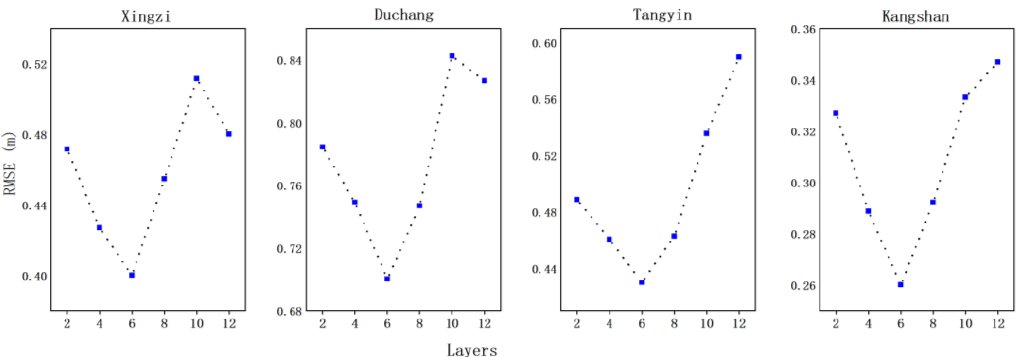
Figure 8. Simulation accuracy (RMSE) under different model layers of Transformer model.